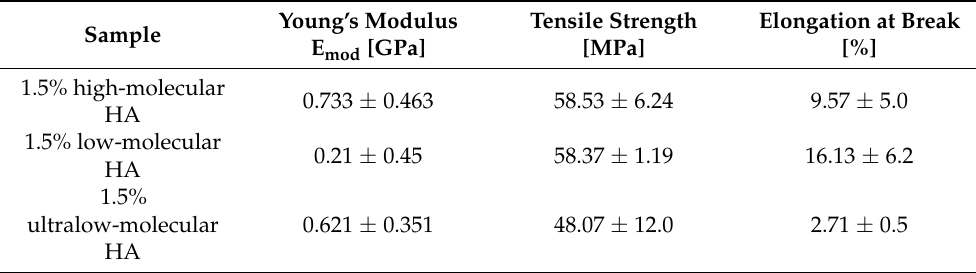
Table 4. Mechanical properties of the film made of the high-, low-, and ultralow-molecular-weight hyaluronic